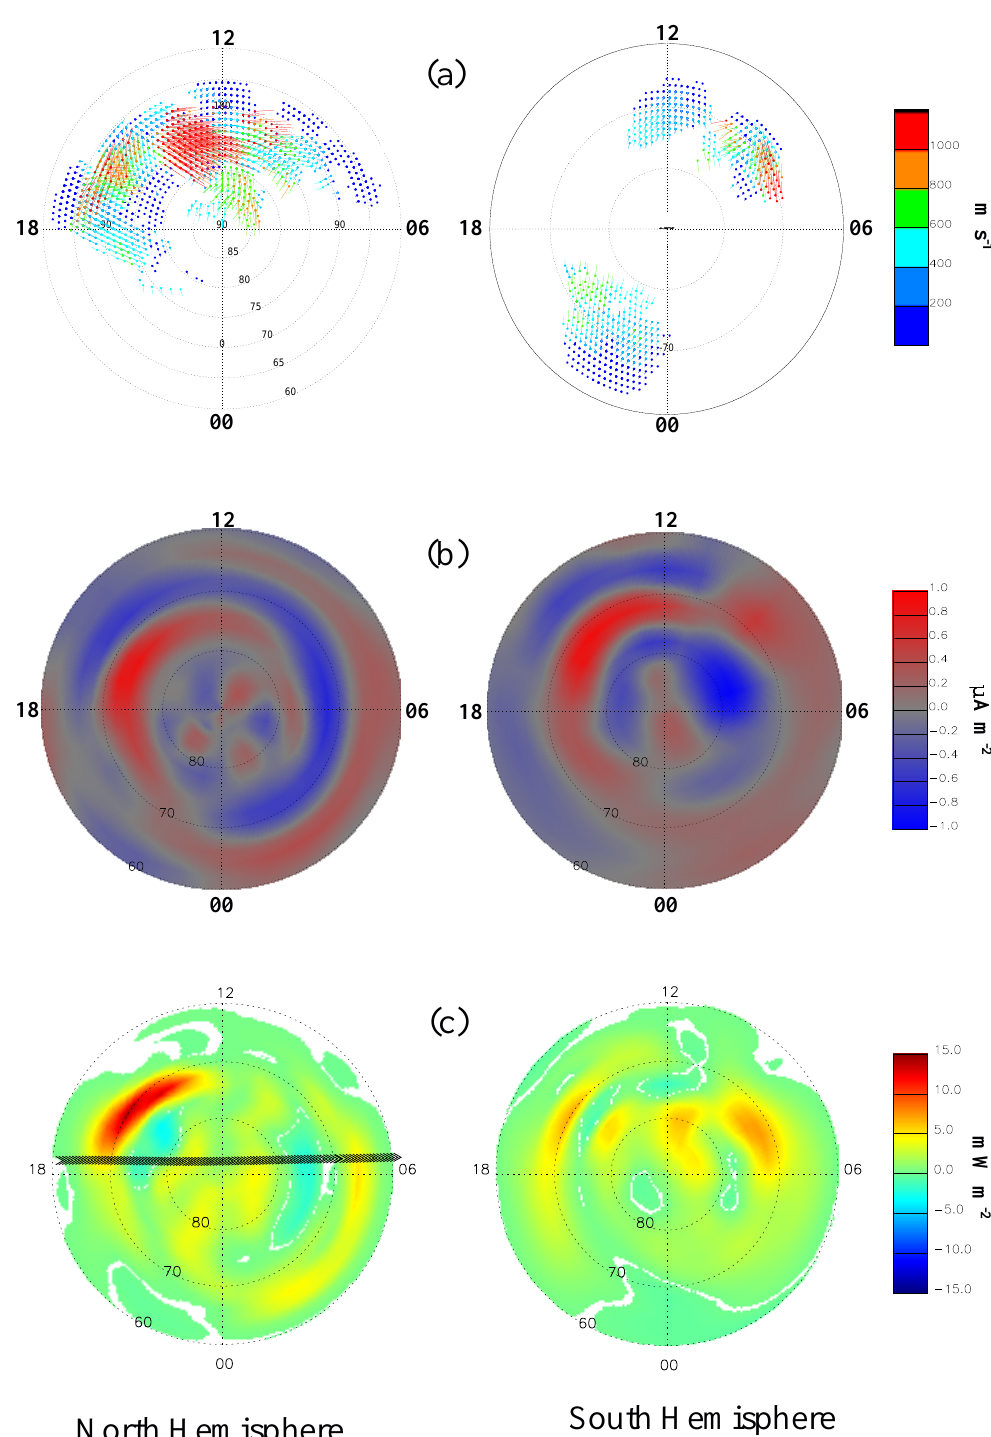
Fig. 5. Iridium and SuperDARN data averaged over 14:00–15:00 UT, 23 November 1999 for both Northern and Southern Hemispheres. ( a ) Plasma velocities from SuperDARN, ( b ) Field-aligned currents derived from the Iridium magnetometer data. Radial outward (inward) currents are red (blue). ( c ) Poynting flux and DMSP F-13 track over the Northern